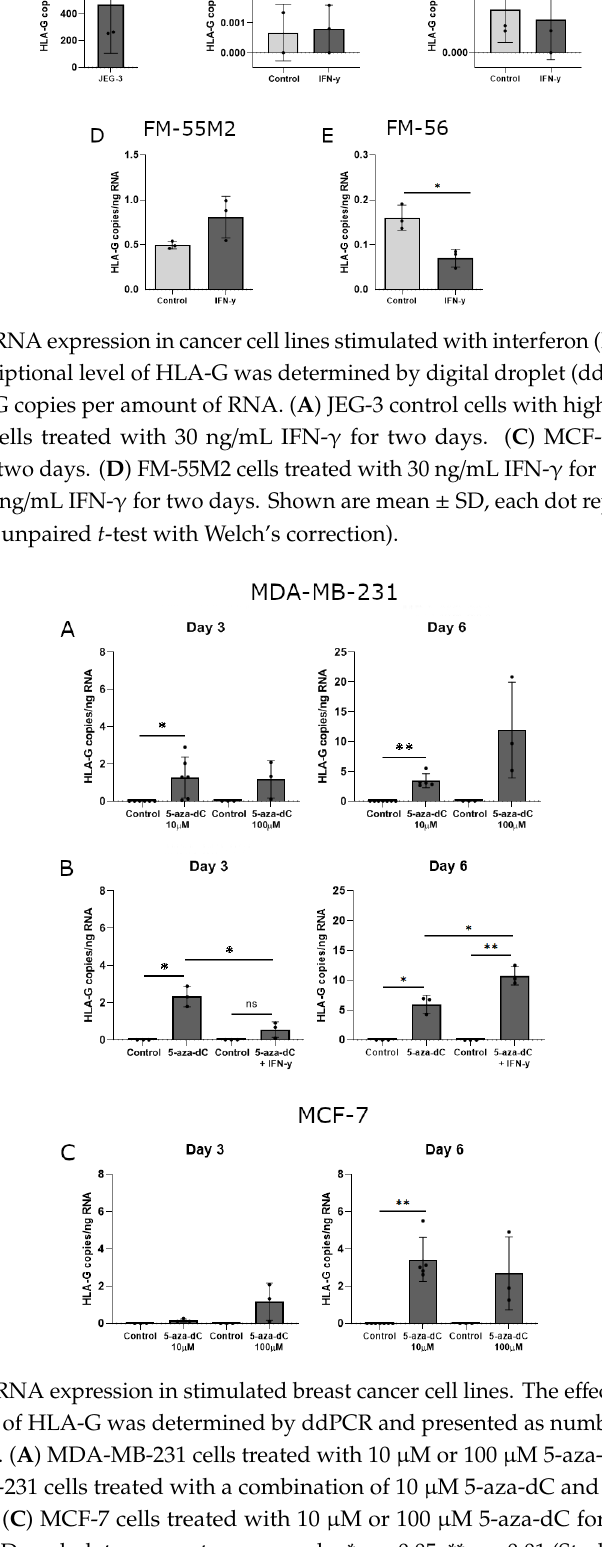
Figure 7. HLA-G mRNA expression in stimulated malignant melanoma cell lines. The effect of 5-aza- dC on the transcriptional level of HLA-G was determined by ddPCR and presented as number of